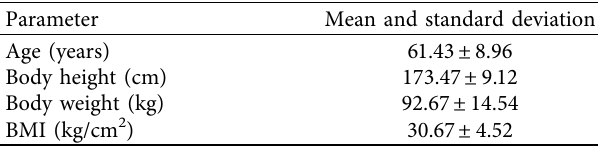
Table 1: Patients’